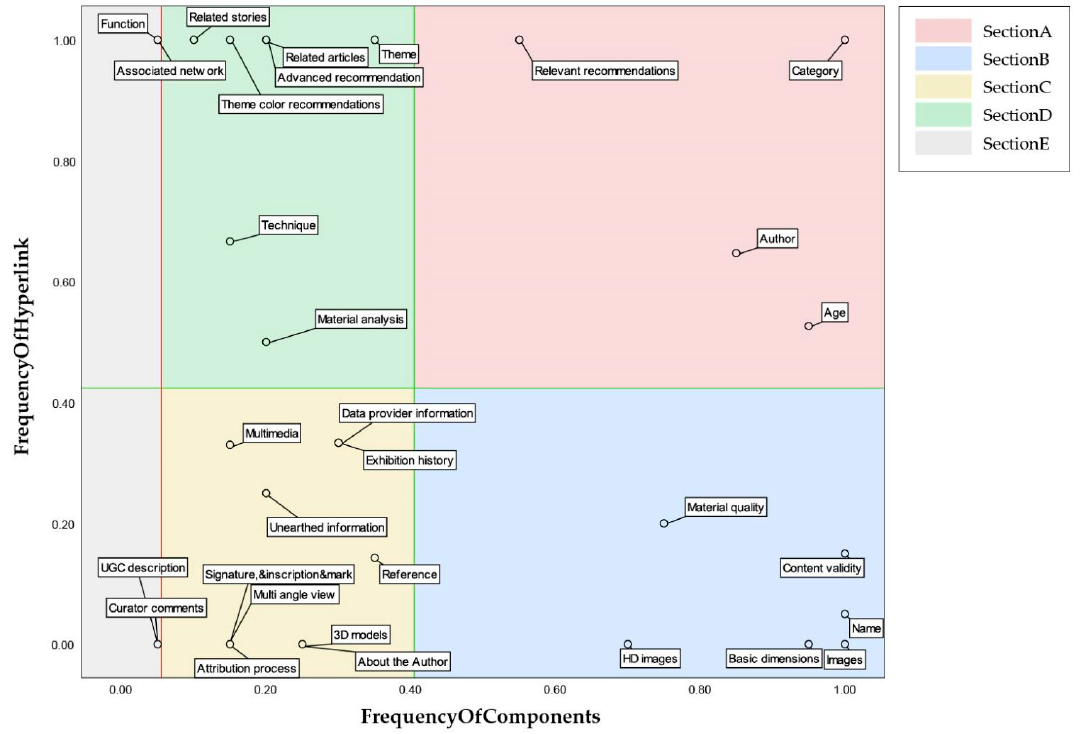
Figure 2. Scatter diagram and zoning of digital museum components.